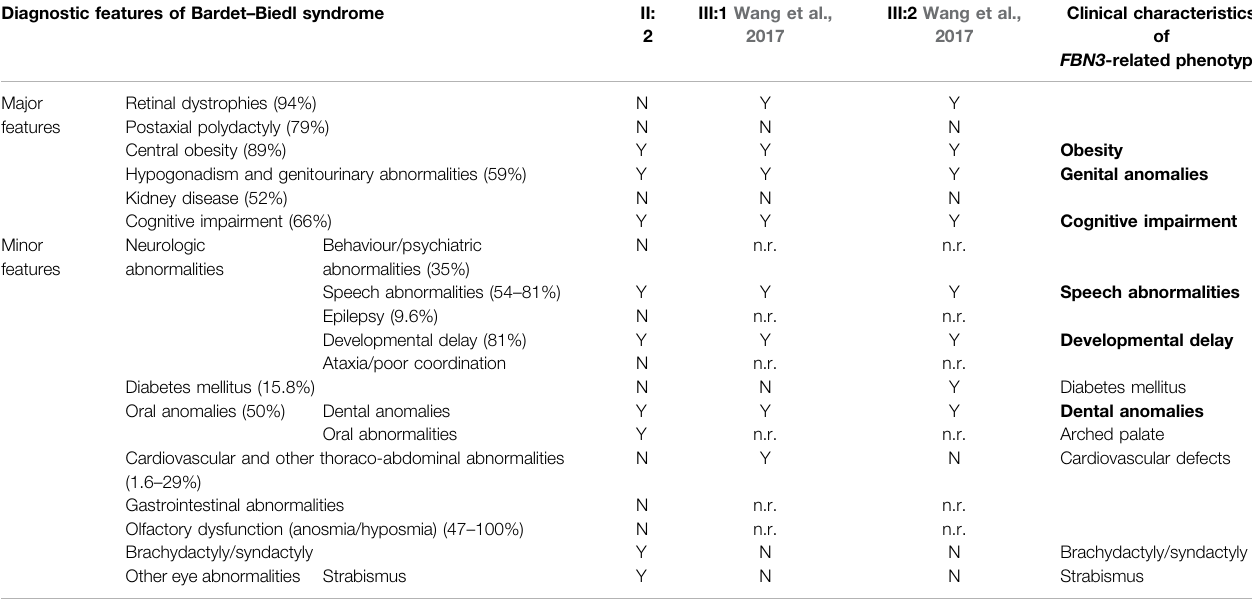
TABLE 1 | Left: diagnostic features of Bardet – Biedl syndrome with their relative prevalence (Forsyth and Gunay-Aygun, 2003; Forsythe and Beales, 2013) and (center) clinical characteristics of our (II:2) and Wang ’ s patients (III:1 and III:2; Wang et al., 2017). Four primary features or three primary features and two secondary features establishthediagnosisofBardet – Biedlsyndrome(ForsythandGunay-Aygun,2003).Right:clinicalcharacteristics(inboldthoseshowedbyallreportedpatients)oftheBBS- like phenotype herein described. N: absent; n.r.: not reported; Y: present. Diagnostic features of Bardet – Biedl